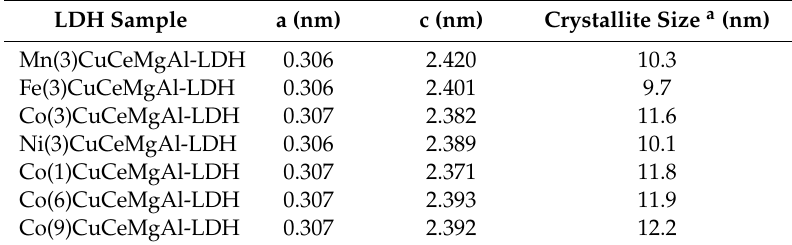
Table 1. Cell parameters and crystallite size of the LDH